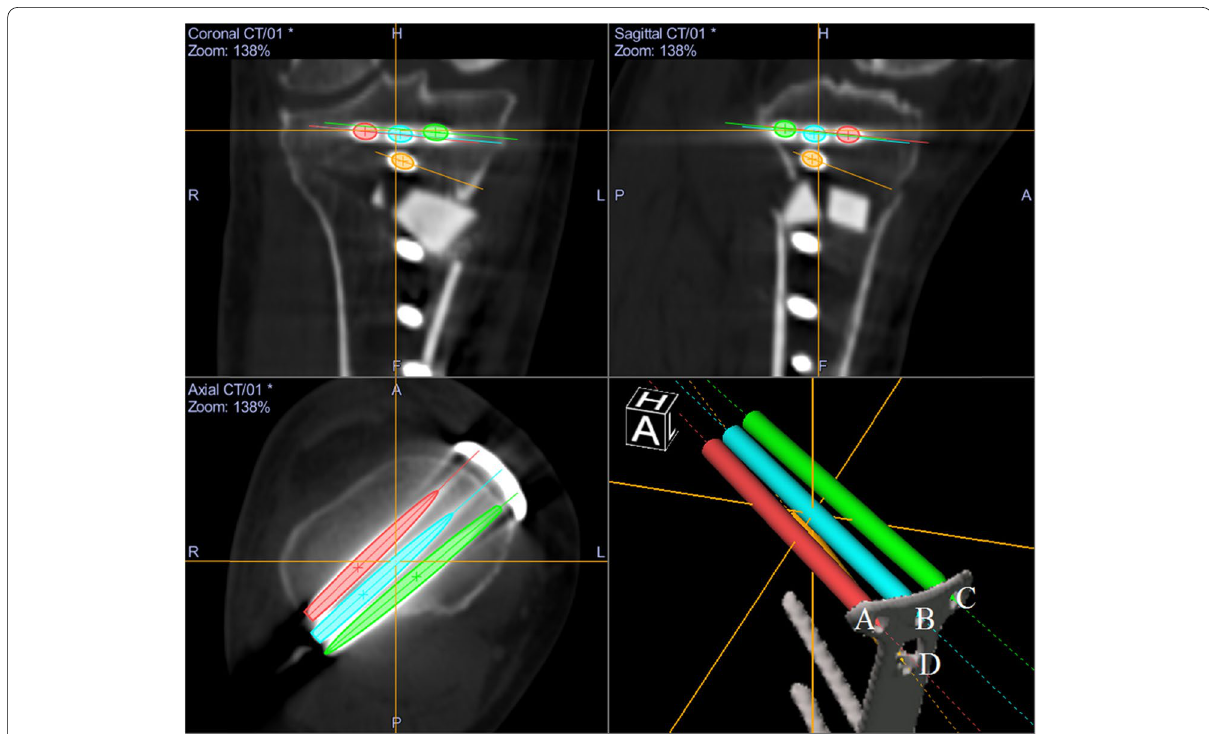
Fig. 3 To avoid halation of locking screws on the CT image, another cylinder was made so that the centre of the cylinder passed the centre of the screw head and the tip of the screw. Four locking screws for the proximal tibial fragment were named A–D screws ( A Proximal anterior screw; B Proximal middle; C Proximal posterior; D